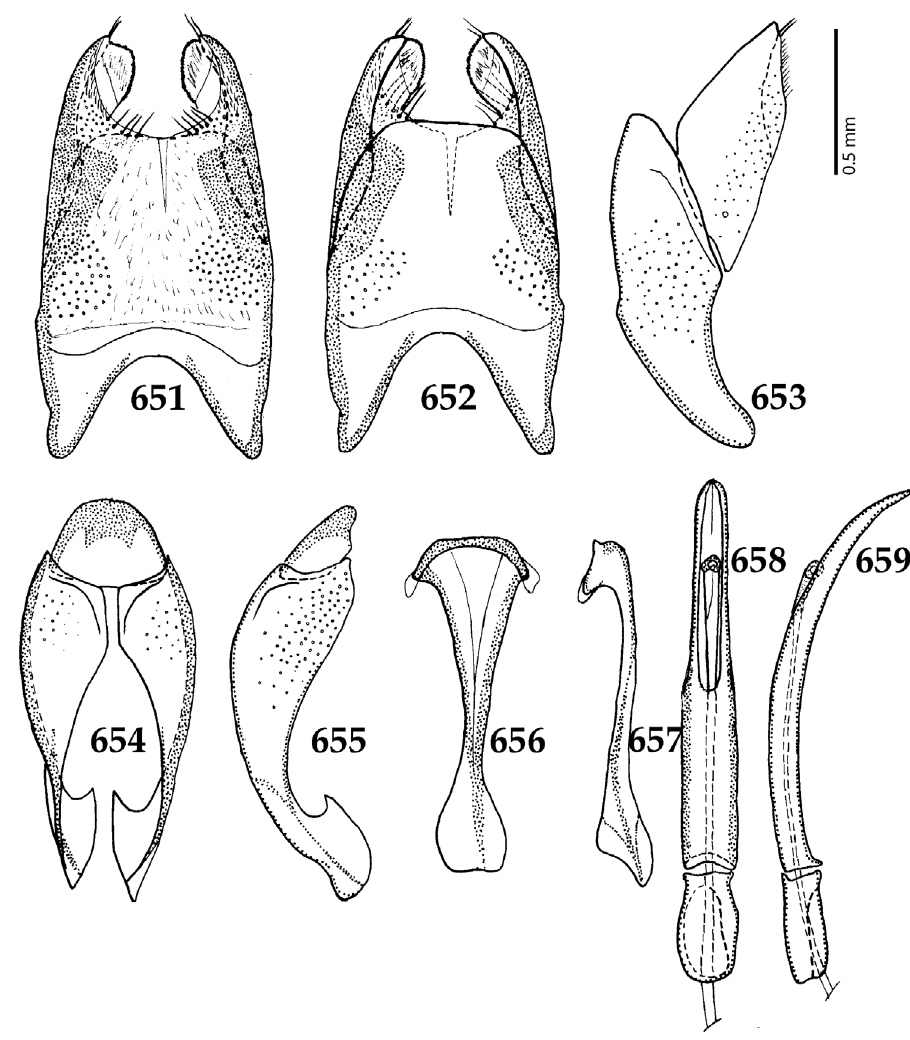
Figures 651–659. 651 Tomogenius incisus (Erichson, 1842) male terminalia: 8 th sternite + 8 th tergite, ventral view 652 ditto, dorsal view 653 ditto, lateral view 654 male terminalia: 9 th + 10 th tergites, dorsal view 655 ditto, lateral view 656 male terminalia: spiculum gastrale, ventral view 657 ditto, lateral view 658 male terminalia: aedeagus, dorsal view 659 ditto, lateral view. Mesotibia (Fig. 646) slender, outer margin with a single row of dense thin denticles growing in size apically; setae of outer row sparse, regular, rather dense but short, growing somewhat longer apically; setae of median row irregular, much shorter than those of outer row; posterior mesotibial stria complete; anterior surface of mesotibia with dense row of well sclerotized short setae, with another similar row of much shorter and finer setae